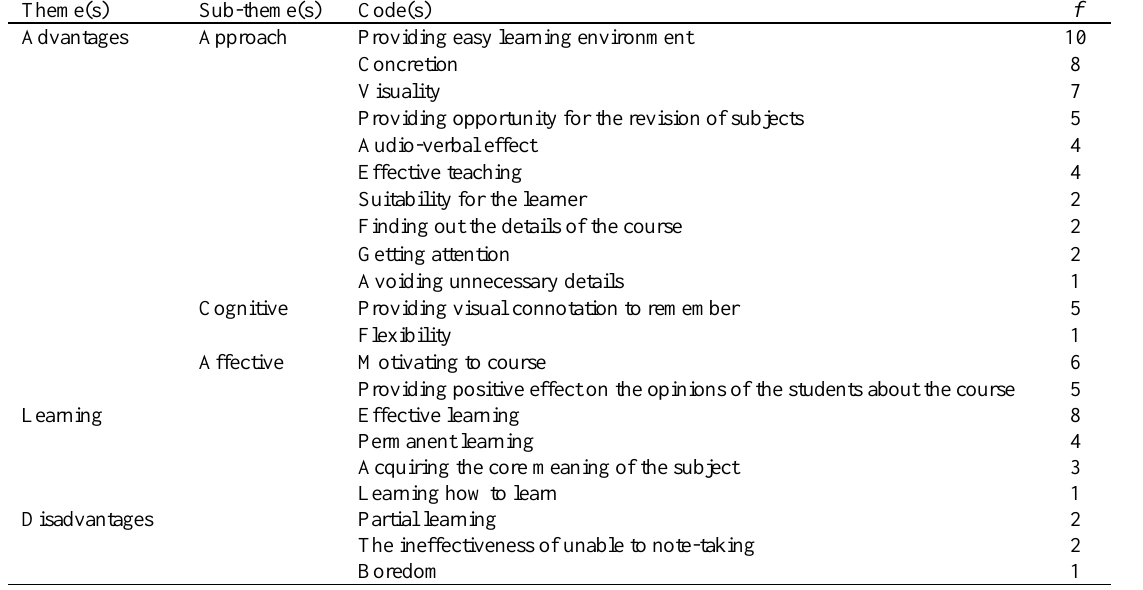
Figure 4 Line chart of students’ pre and post-BA scores Table 4 Content analysis of the students’ interviews in Mbio group ( n =